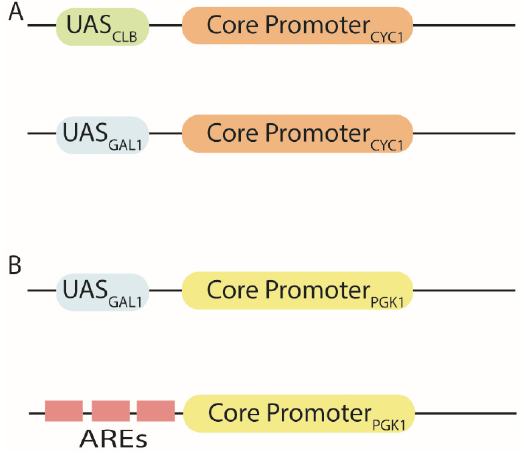
Figure 2. Hybrid promoters. ( A ) The CYC1 core promoter was merged to different UASs to construct either constitutive or inducible (here galactose-responsive) hybrid promoters [39]. ( B ) The PGK1 core promoter was turned, as well, into a galactose-inducible hybrid promoter when preceded by the UAS from pGAL1. The substitution of UAS GAL1 with androgen-responsive elements (AREs) led to a new hybrid promoter induced by testosterone [41].